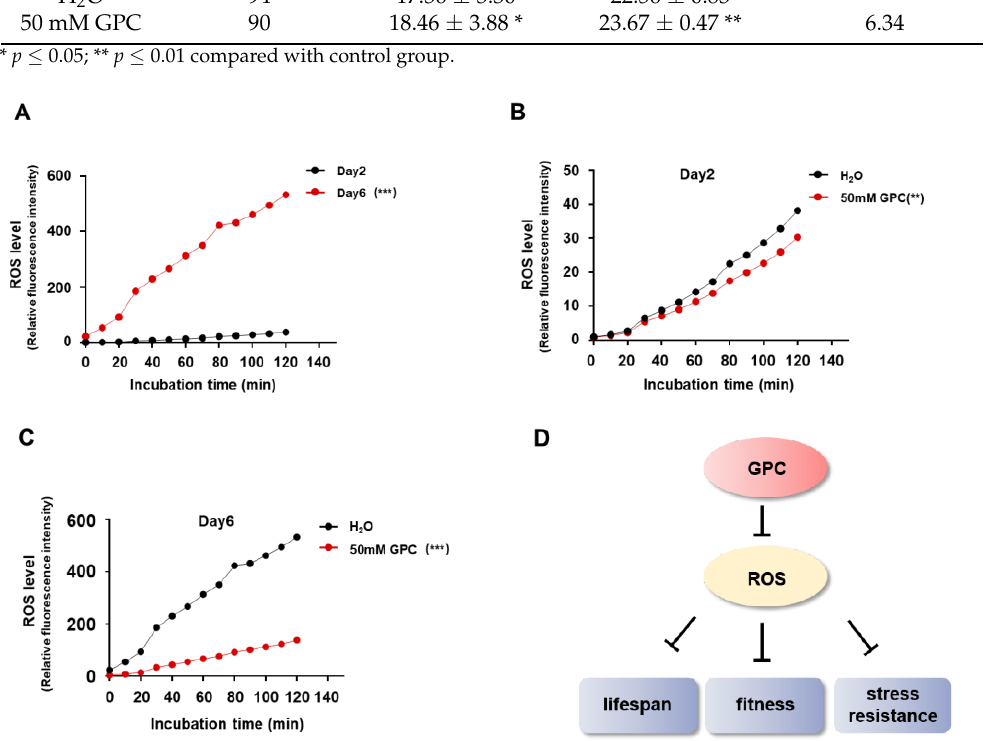
Mean Lifespan Maximum Lifespan (Days) (Days)